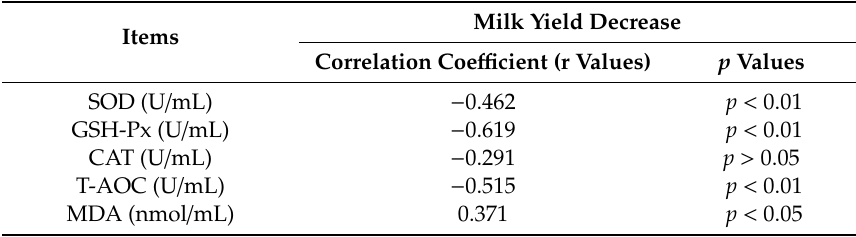
Table 3. Correlation analysis between serum antioxidant capacity and the milk yield. Milk Yield Decrease Items Correlation Coe ffi cient (r Values) p